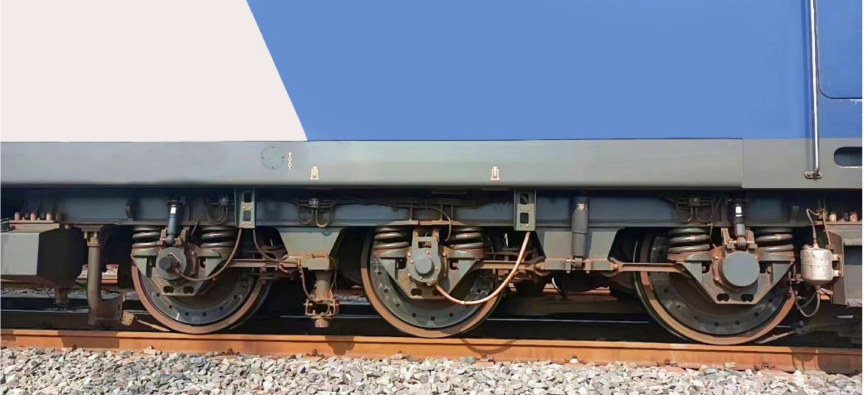
Figure 6. The locomotive bogie in refurbishment test after the